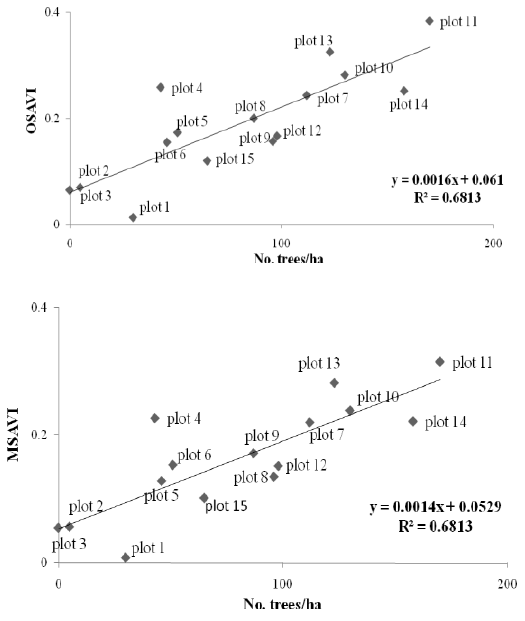
Figure 6. Relationships between tree density and vegetation indices (VIs)